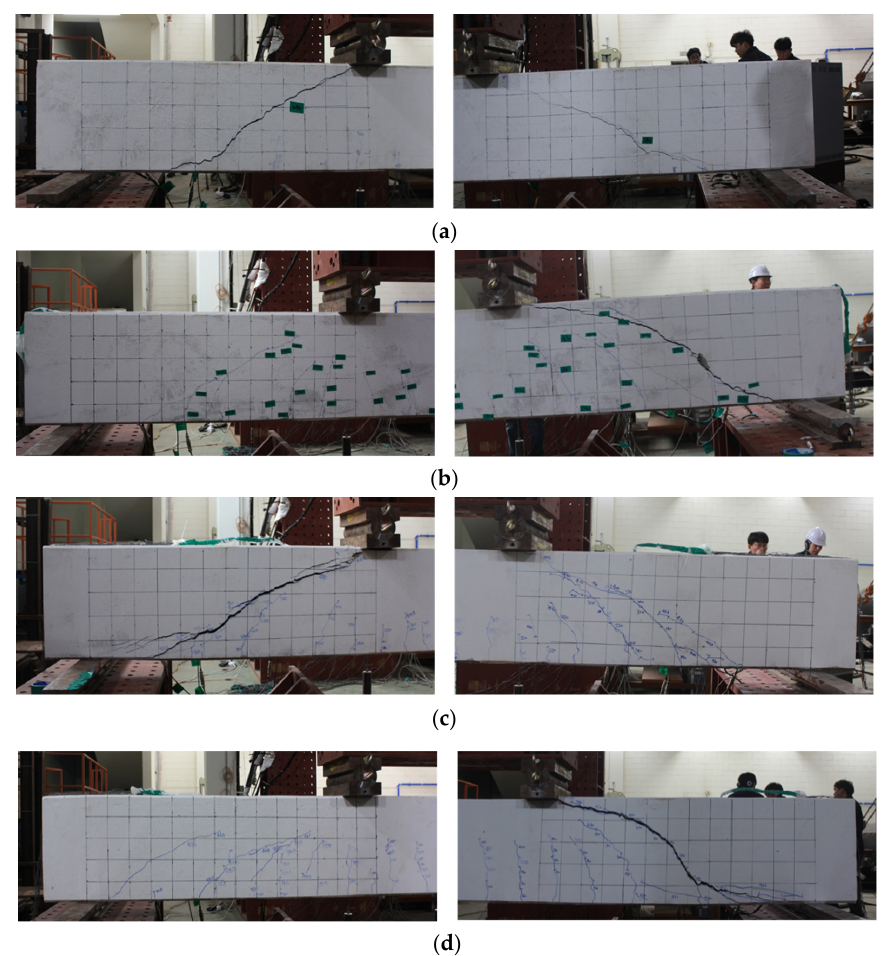
Figure 7. Crack patterns at failure (enlargement). ( a ) BS-0. ( b ) BS-N. ( c ) BS-2T. ( d ) BS-2.5T.